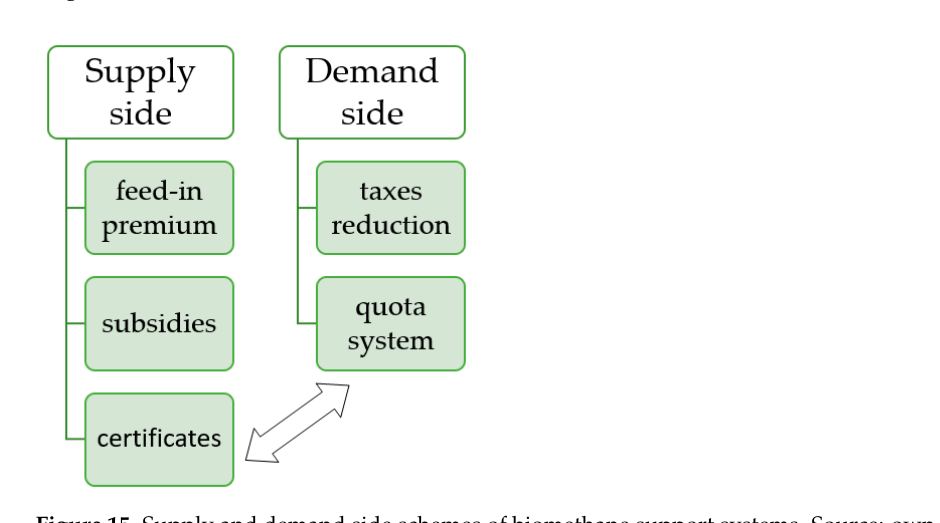
Figure 15. Supply and demand side schemes of biomethane support systems. Source: own elabora- tion.